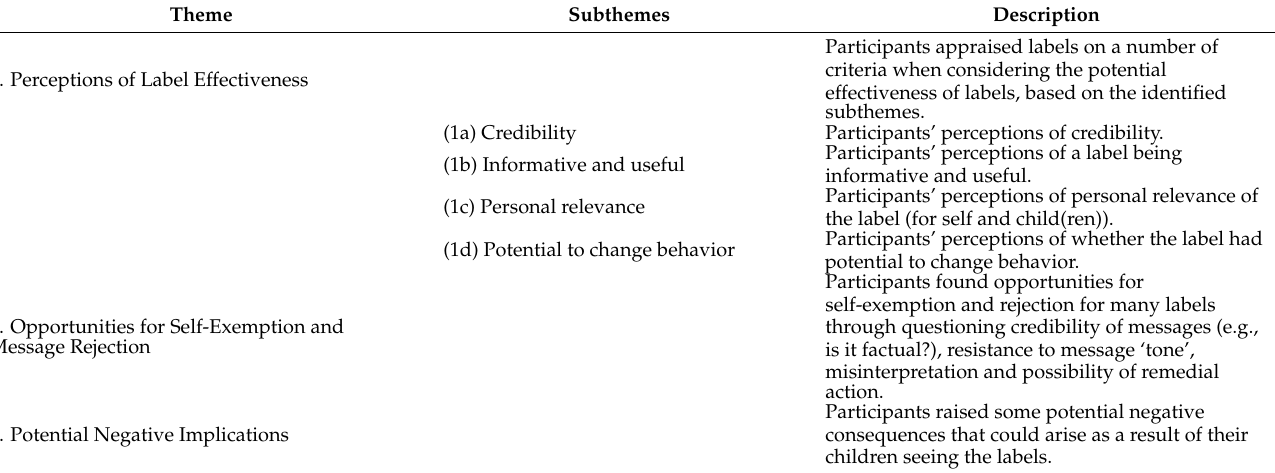
Table 3. Themes and